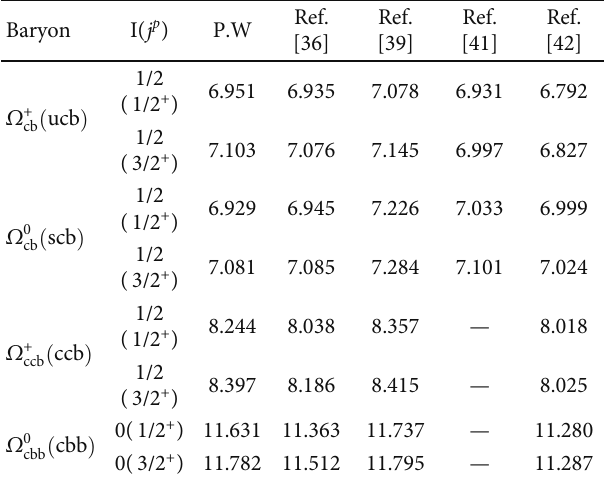
Table 9: charm and beauty baryon masses in the ground state (masses are in GeV) at ( αβ = 0 : 2 ).